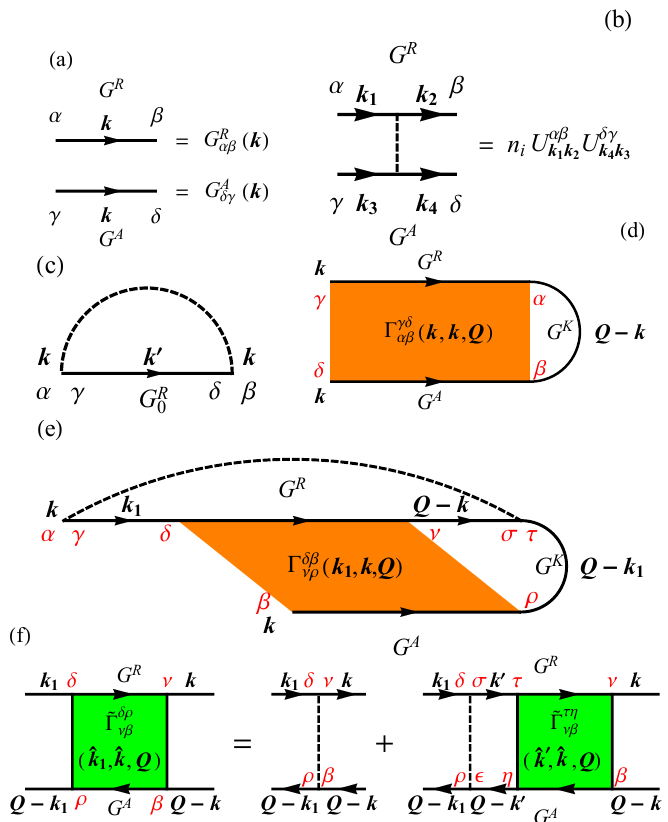
Figure 2. The diagrams for the weak (anti-)localization conductivity of Dirac fermions. ( a ) definition of the Green’s functions as arrowed solid lines in which Greek letters are spin indices; ( b ) definition of dashed lines: impurities lines expressed in both retarded and advanced cases; ( c ) the retarded self-energy in the first-order Born approximation, where G R is the bare retarded Green’s function. 0 This contribution to the self energy represents the classical picture of electrons scattering off randomly Σ K,b distributed impurities; ( d , e ) are Keldysh self-energies and Σ K,R of maximally crossed diagrams k , γδ k , αβ in the bare and the retarded dressed cases, respectively, where Γ is the Cooperon structure factor. (cid:1) (cid:0) Both of these represent contributions due to quantum interference in scattering processes: an electron travelling through a disordered region can backscatter and return to its starting point. The loop can be performed clockwise or anticlockwise, and, in quantum mechanics, the two trajectories interfere. Note that ( e ) vanishes in the absence of spin-orbit coupling; ( f ) the Bethe-Salpeter equation for the twisted Cooperon structure factor ˜ Γ